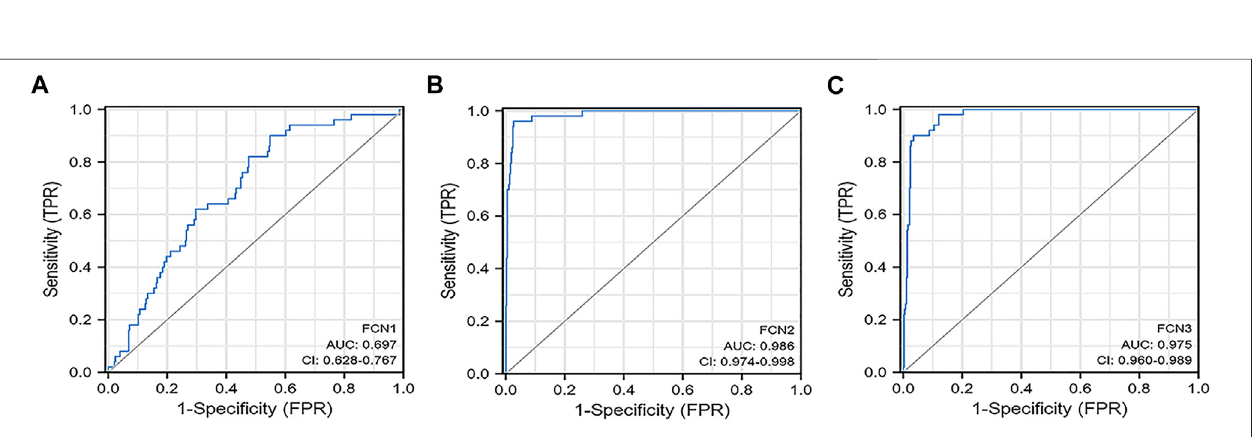
FIGURE 4 | The diagnostic value of FCNs in LIHC patients. (A) FCN1; (B) FCN2; (C) FCN3.